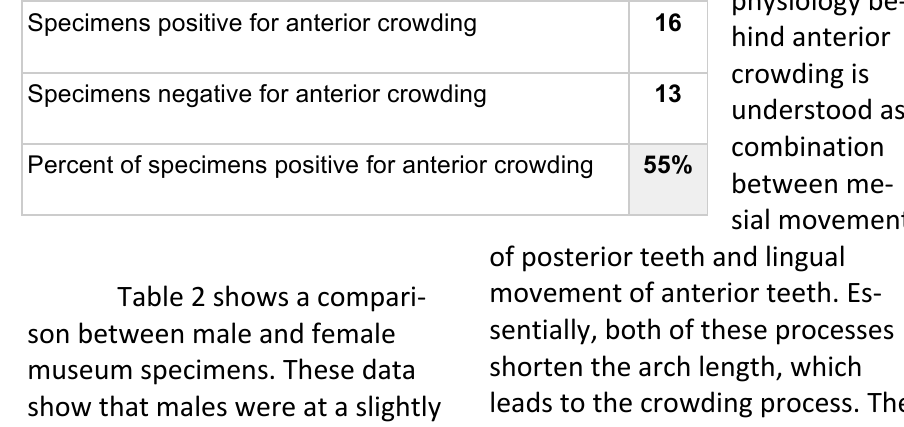
Table 1. Prevalence of anterior crowding found in the observed population Specimens positive for anterior crowding 16 Specimens negative for anterior crowding